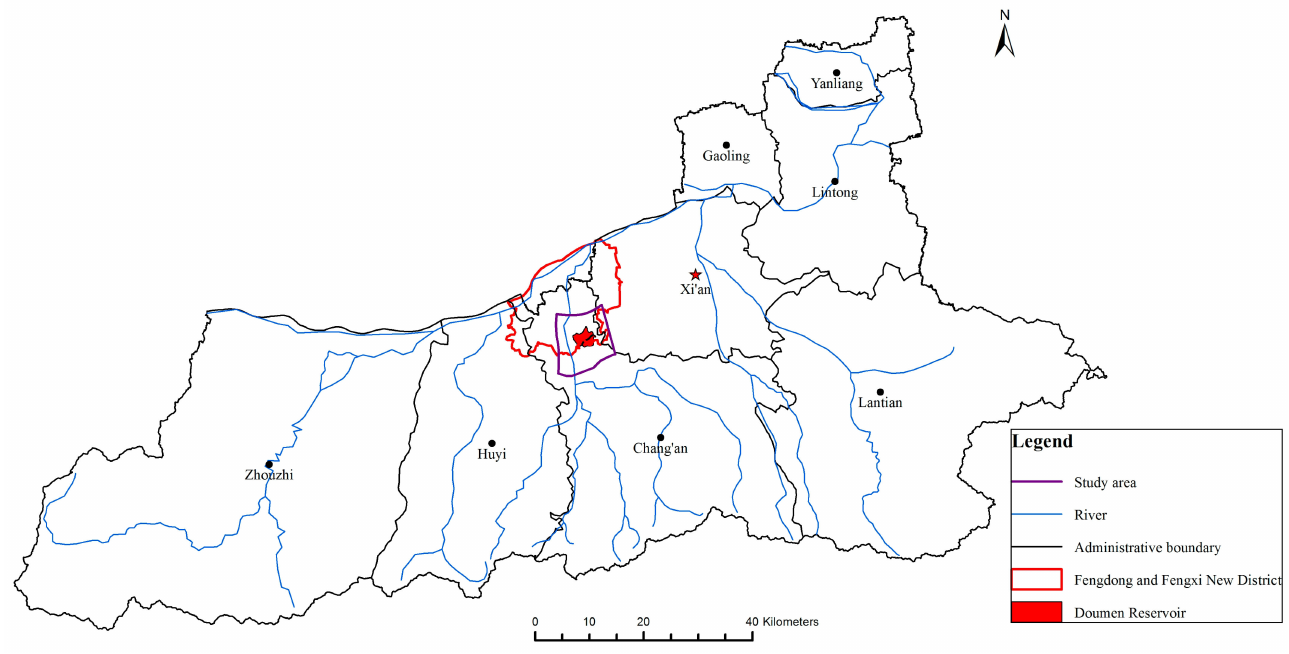
Figure 1. Location of the Doumen Reservoir (DR) and study